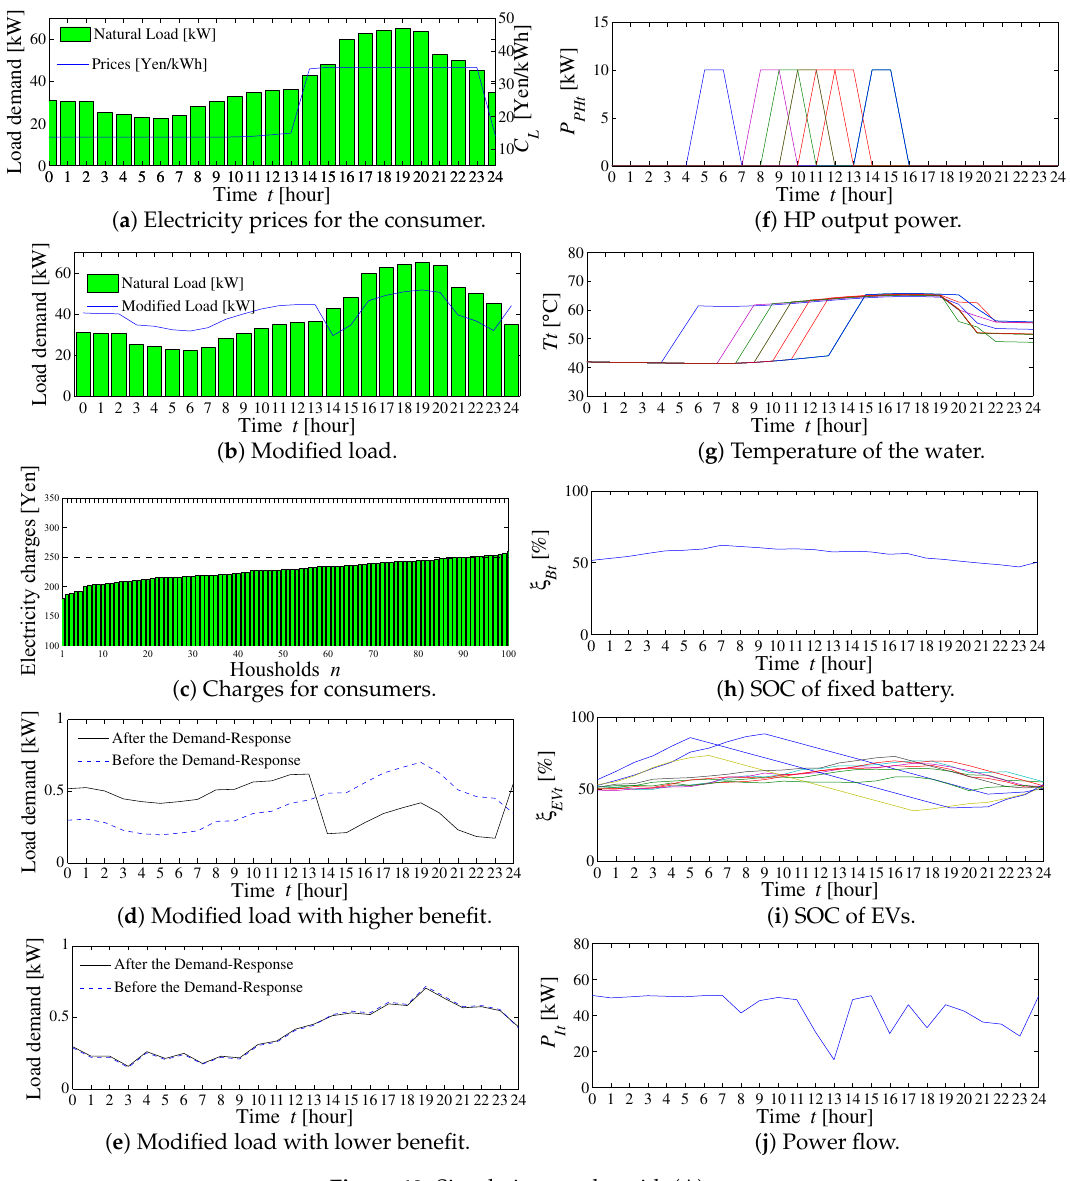
Figure 12. Simulation results with